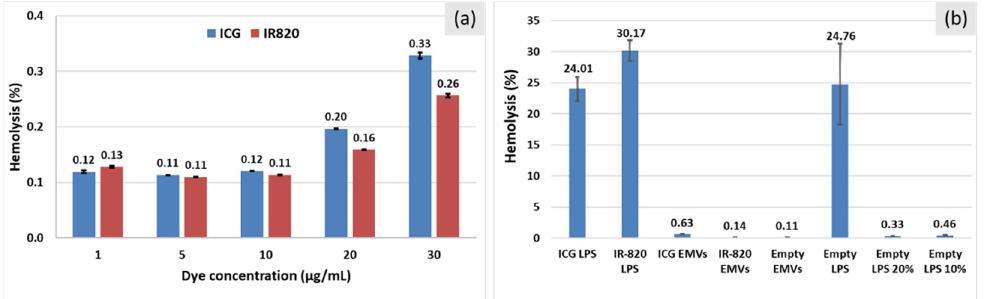
Figure 10. Influence of ICG and IR-820 dyes on red blood cells toxicity. All measurements were performed in triplicate. ( a ) Hemolysis determination of PBS solutions of dyes in the concentration range from 1 to 30 µ g/mL after 3 h incubation at 37 ◦ C. Data analysis revealed no statistically significant difference in the cell viability values between tested groups (ICG and IR-820 at a given concentration, p > 0.05) up to 10 µ g/mL. At a higher concentration (20 and 30 µ g/mL), hemolysis values become significantly different between tested groups ( p < 0.05). ( b ) Hemolysis determination of dye-containing liposomes (LPS) and EMVs after 3 h incubation at 37 ◦ C. Empty carriers were tested as control groups. Liposomal samples (without dilution) showed a statistically significant difference between hemolysis values (ANOVA test, F > F critical = 20.09 > 5.14, p < 0.005). Hemolysis values for all EMV samples differed significantly (ANOVA test, F > F critical = 34.89 > 5.14, p <